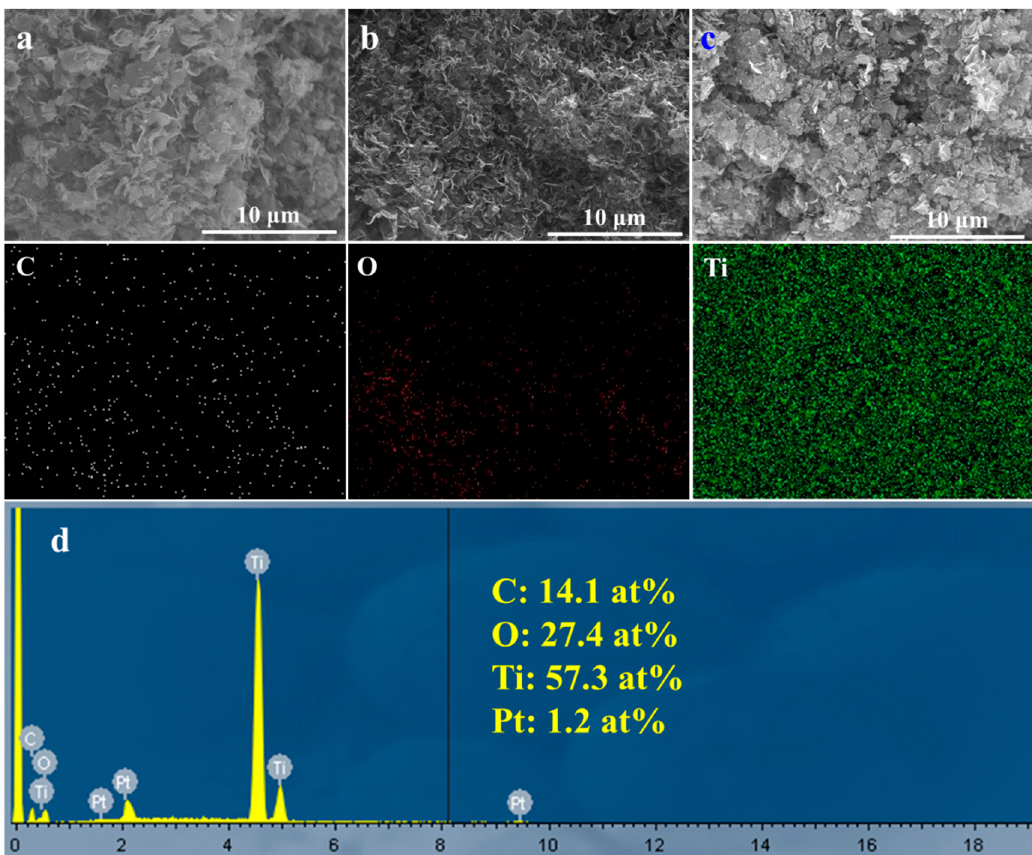
Figure 8. SEM images of the char residues for ( a ) PS/DTAB-Ti 3 C 2 , ( b ) PS/OTAB-Ti 3 C 2 and ( c ) PS/DDAB-Ti 3 C 2 ; ( d ) energy dispersive X-ray (EDX) spectrum and atomic percentage of the residue for PS/OTAB-Ti 3 C 2 .